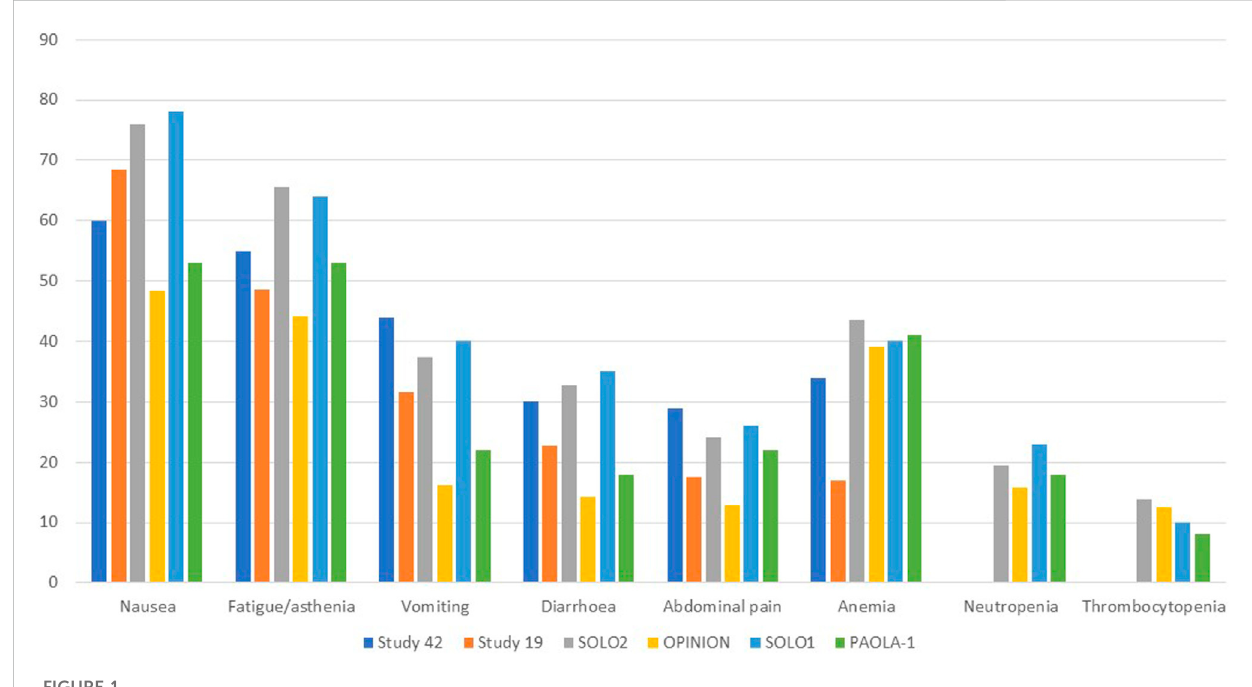
FIGURE 1 Most frequent all-grades adverse events during olaparib therapy.